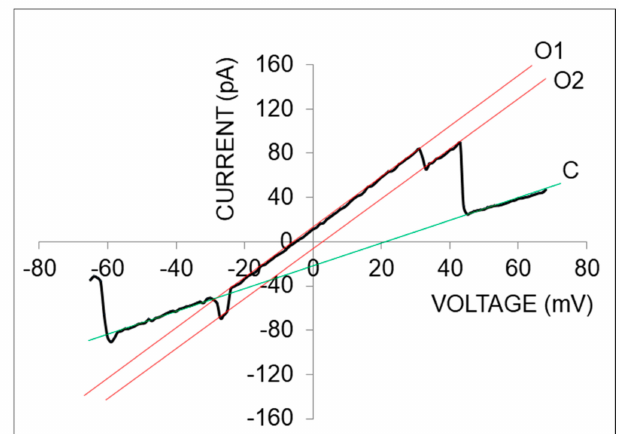
Figure 1. Typical current-voltage curve of single PcVDAC ( Phaseolus coccineus voltage-dependent anion channel) recorded in the presence of a ten-fold KCl concentration ratio ((1/0.1 M KCl; Trans/Cis) across the membrane (12 replicates). The solutions were buffered at pH 7.5 with 10 mM HEPES-KOH. The straight lines drawn through the graph correspond to either the canonical anion open state (O1) or the more cation selective open state (O2) or the cation selective lower-conductance substate (C). A positive reversal potential (V (I = 0)) indicates a higher selectivity towards cations whereas a negative reversal potential indicates a higher selectivity towards